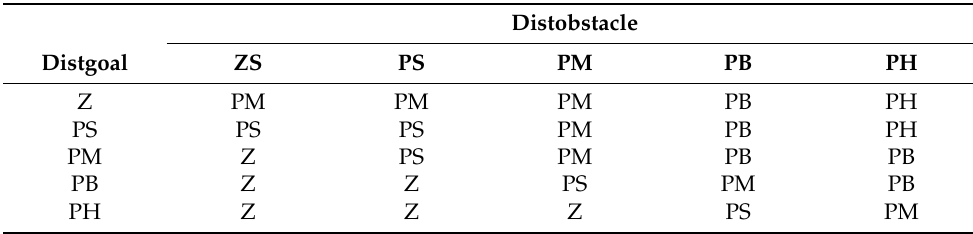
Table 2. Fuzzy control rules of Distgoal, Distobstacle, and ε goal .